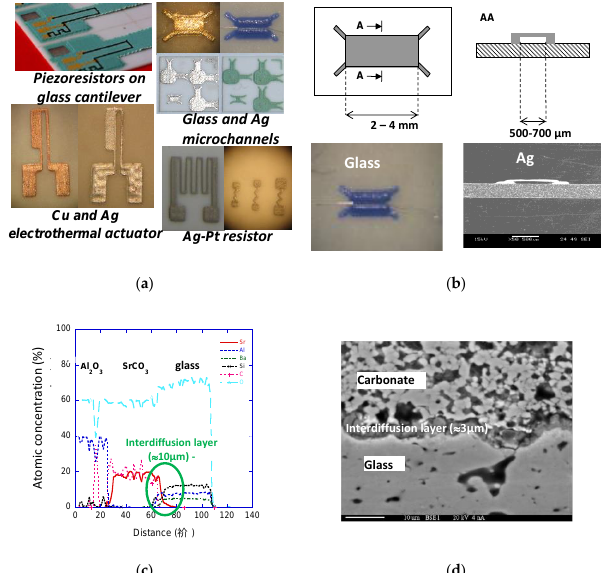
Figure 4. Thick-film ceramic MEMS associating screen-printing with an SrCO 3 -epoxy sacrificial layer. ( a ) Photographs of successfully fabricated microstructures. ( b ) Dimensions, photograph, and SEM images of microchannels. ( c , d ) Interface glass/SrCO 3 analysis revealing the presence of strontium: ( c ) Castaing microprobe analysis after firing under air of the cross section of the interface glass/SrCO 3 ; ( d ) SEM image after firing under air + 5% CO 2 [32].